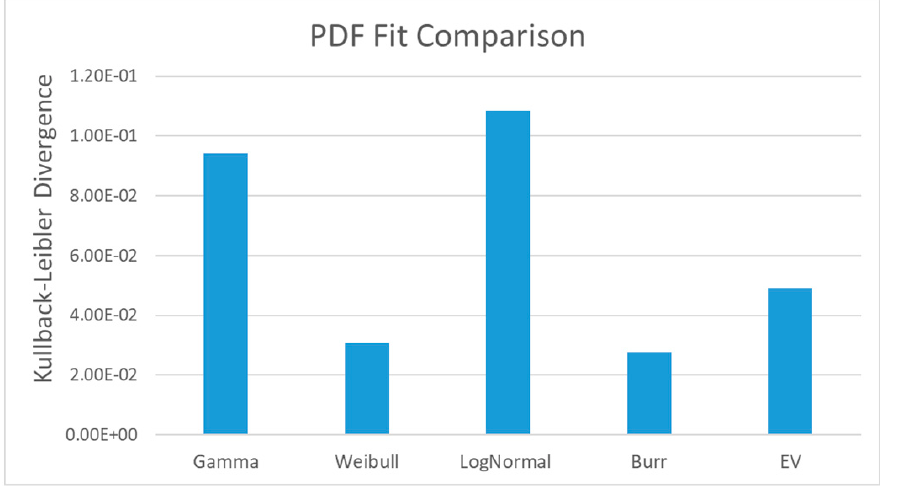
Figure 2. The Kullback–Leibler divergence values for Gamma, Weibull, Lognormal, Burr and Extreme-Value distribution.